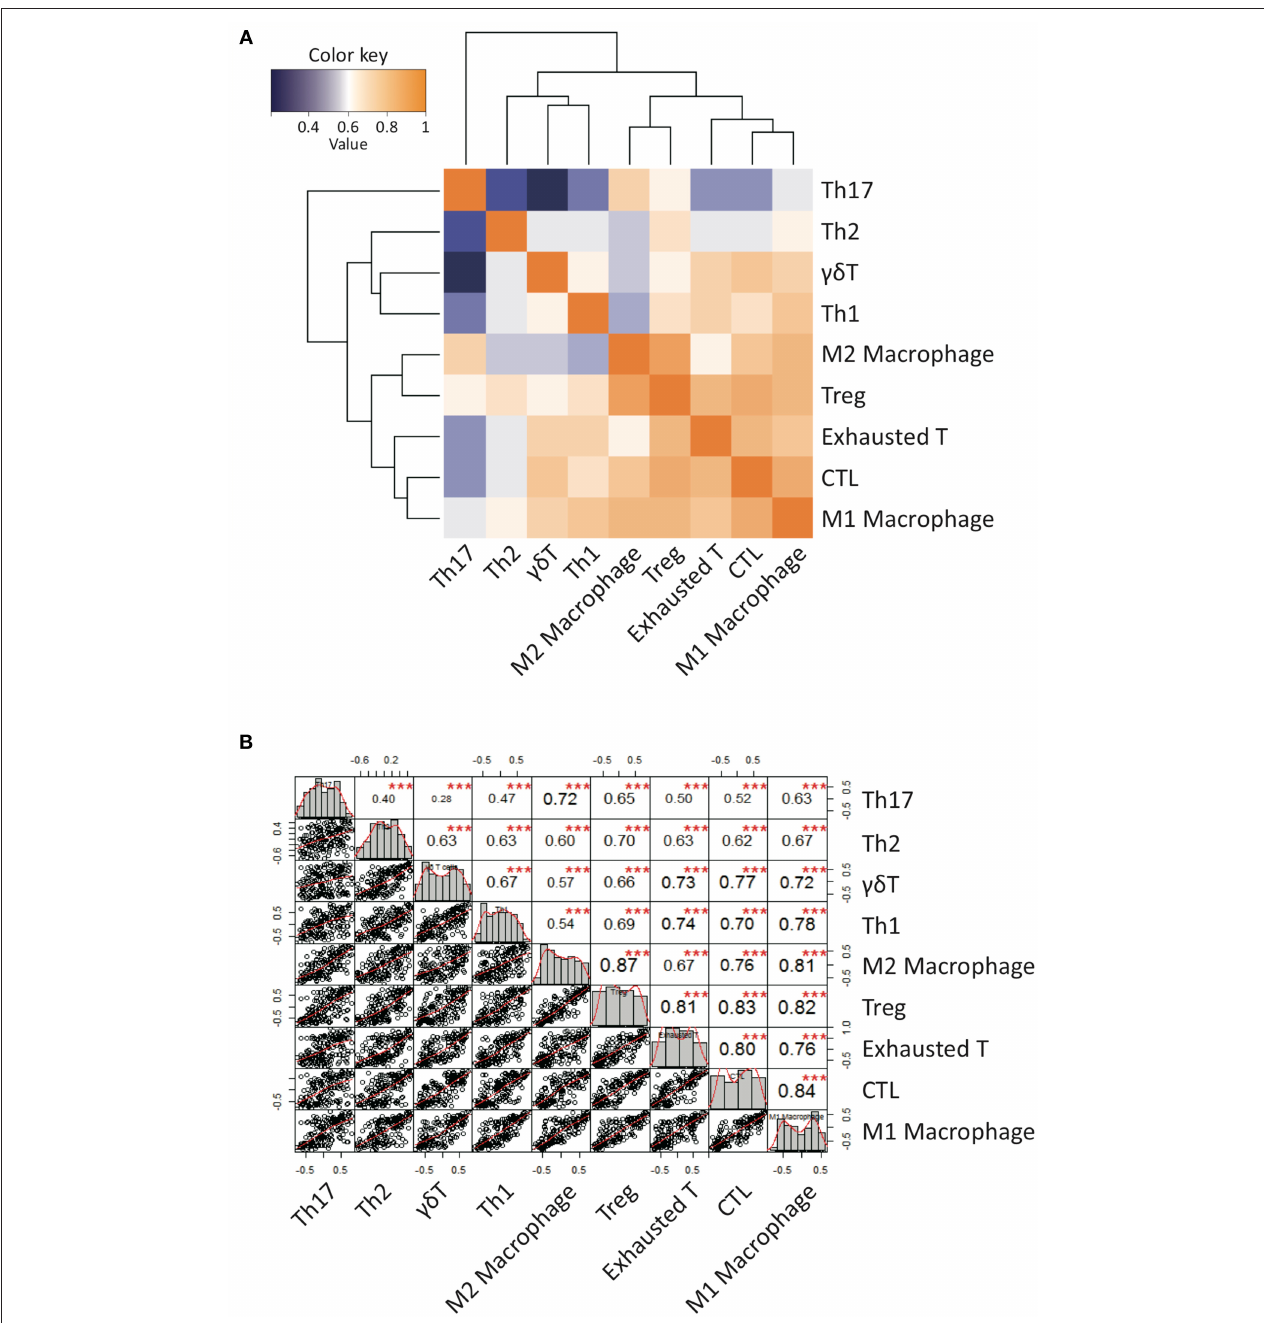
FIGURE 2 | Correlation patterns of Gene Set Variable Analysis (GSVA) enrichment scores of a variety of curated immune gene signatures for 170 GBM patients from TCGA database. (A) A clustered heatmap of Pearson’s correlation coefficient of GSVA scores over all immune signature gene sets. Hierarchical clustering was performed based on Pearson’s correlation distance with ward linkage method. Dark orange denotes high correlation ( r = 1) while dark blue denotes a lack of correlation ( r > 0). (B) The diagonal of the chart represent distribution of GSVA enrichment scores. The bivariate scatter plots of linear regression fits of each pairs with the fitted lines are shown on the bottom of the diagonal. Pearson’s correlation coefficient values with the level of significance were shown on the top of the diagonal. *** P <